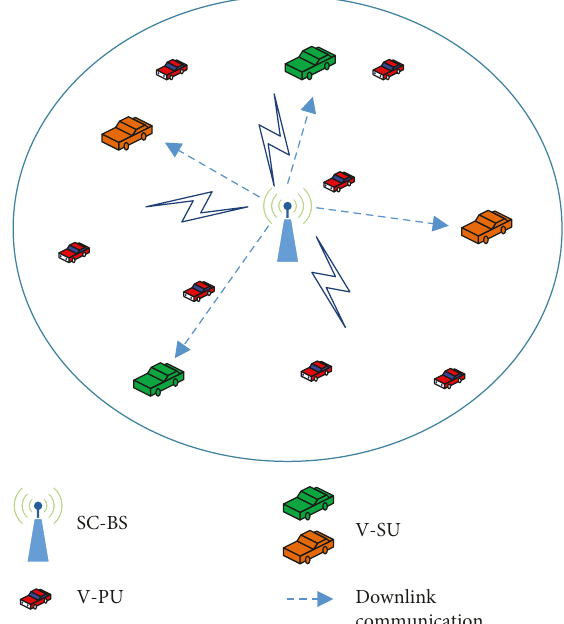
Figure 1: Spectrum sharing problem in vehicle-enabled cognitive small-cell